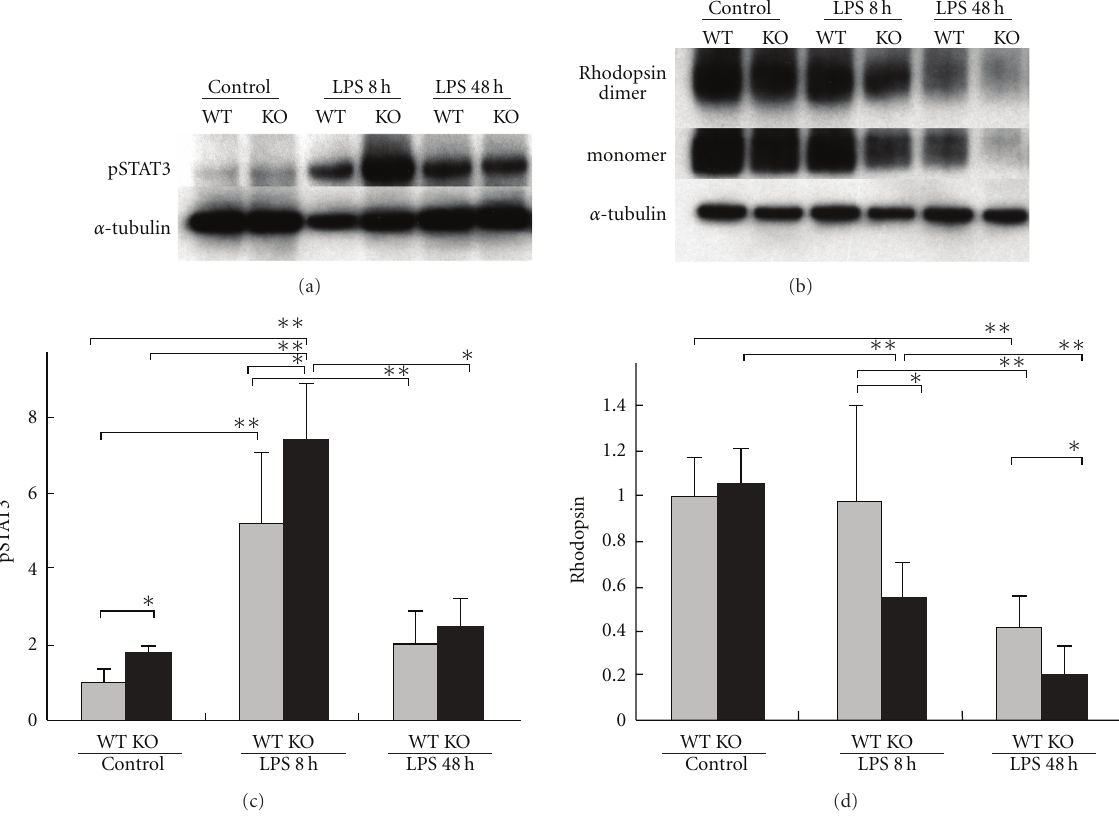
Figure 2: STAT3 activation and rhodopsin protein levels in the retina of EIU model generated in SOCS3CKO mice. Immunoblot analyses. In the SOCS3CKO retina, phosphorylated and activated STAT3 are upregulated in the control condition, and more greatly increased in the EIU model induced by LPS (a, c). Although the rhodopsin protein level in the adult SOCS3CKO retina is almost the same as wild-type retina under control condition, its level was more severely reduced in the EIU model induced by LPS (b, d). WT: wild-type; KO, SOCS3CKO; LPS: lipopolysaccharide; pSTAT3: phosphorylated STAT3; EIU: endotoxin-induced uveitis. This research was originally published in J Biol Chem . Ozawa Y, et al. Roles of STAT3/SOCS3 Pathway in Regulating the Visual Function and Ubiquitin-Proteasome-dependent Degradation of Rhodopsin during Retinal Inflammation. J Biol Chem . 2008; 283(36):24561–24570. the American Society for Biochemistry and Molecular